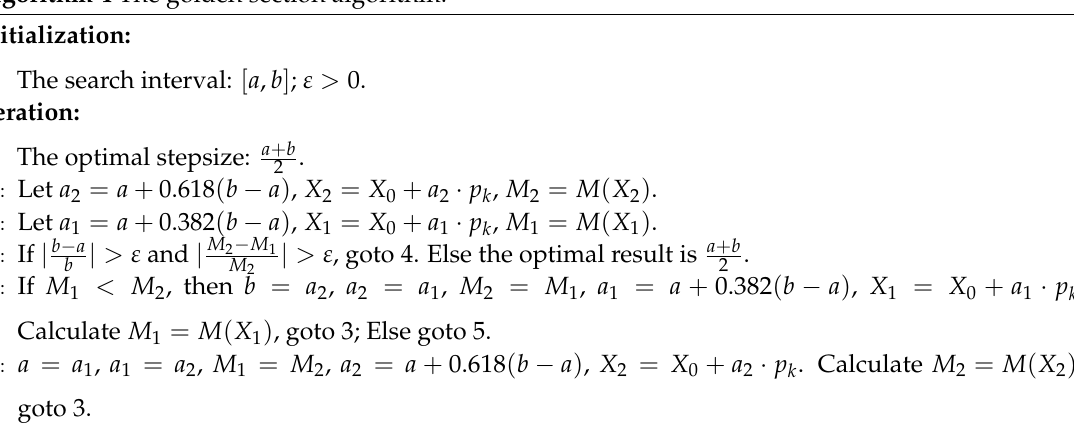
Algorithm 4 The golden section